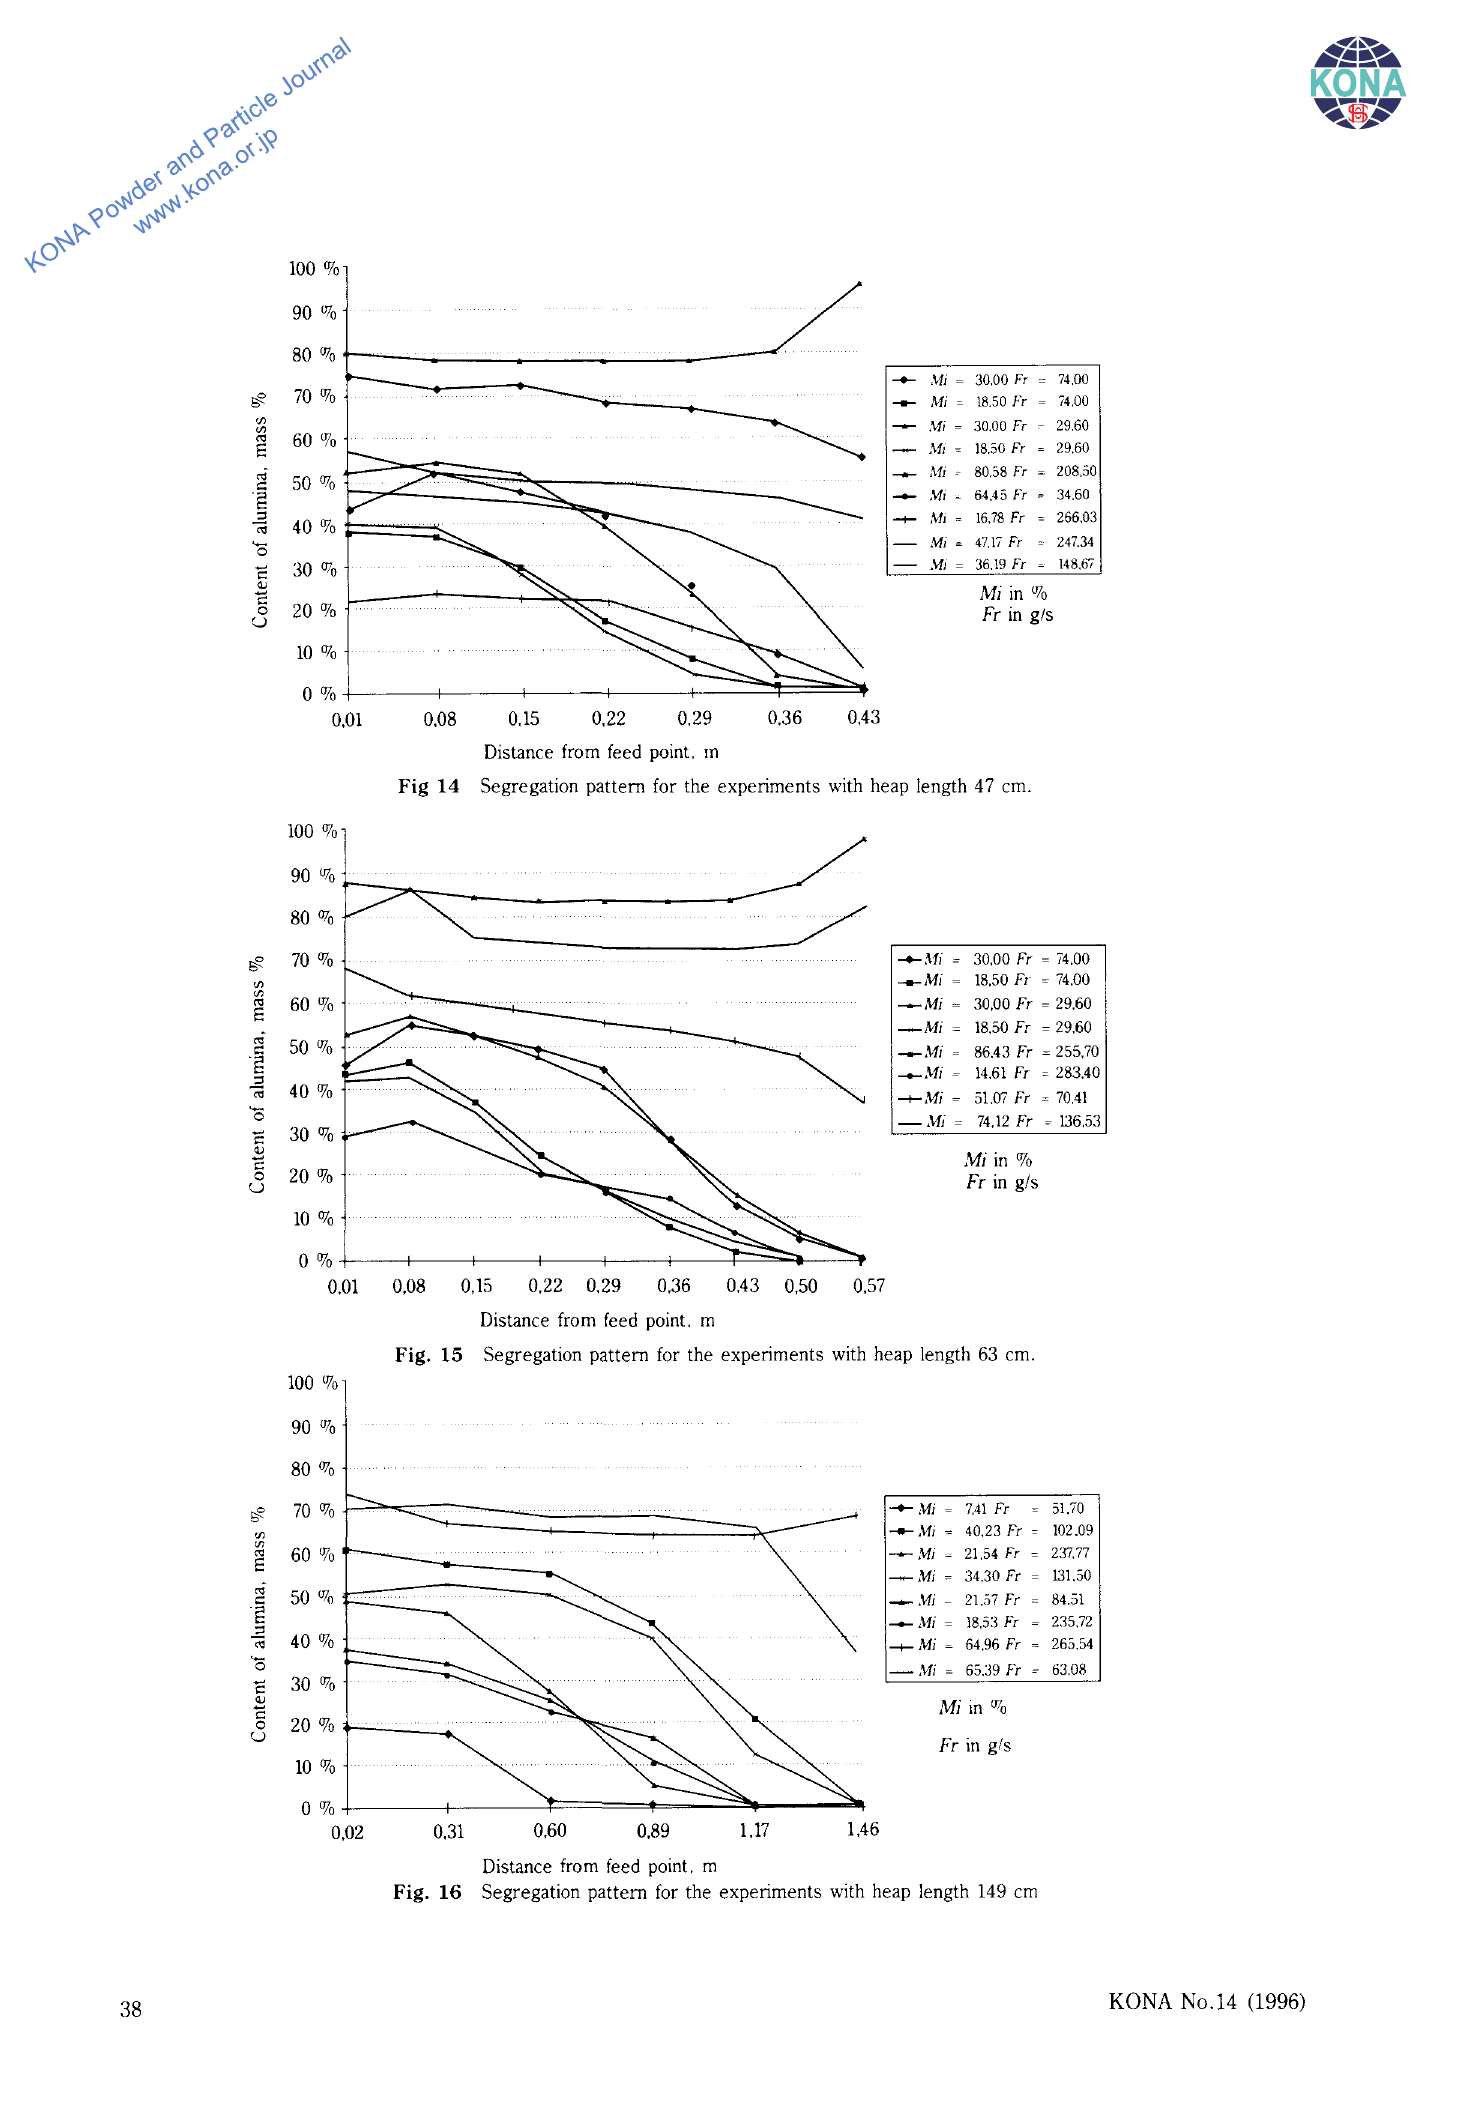
Fig. 15 Segregation pattern for the experiments with heap length 63